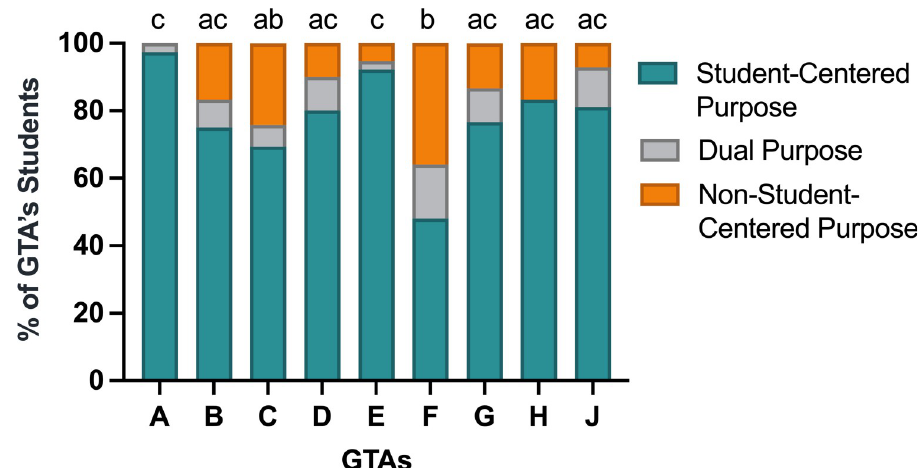
Fig 4. GTAs impact how students perceive the purpose of participating in a CURE. We coded student reflection questions to identify the proportion of each GTA’s students who believed that the university employed CUREs in introductory biology labs for student-centered purposes or non-student-centered purposes. Letters above bars indicate significant differences in the proportion of a GTA’s students who believe that the CURE has a non-student centered purpose: bars that do not share a common letter indicate a significant difference in perceived purpose for students of the indicated GTA. Most students believed that the CURE served a student-centered purpose; however, students of GTAs C and F more frequently reported that the CURE served a non-student centered